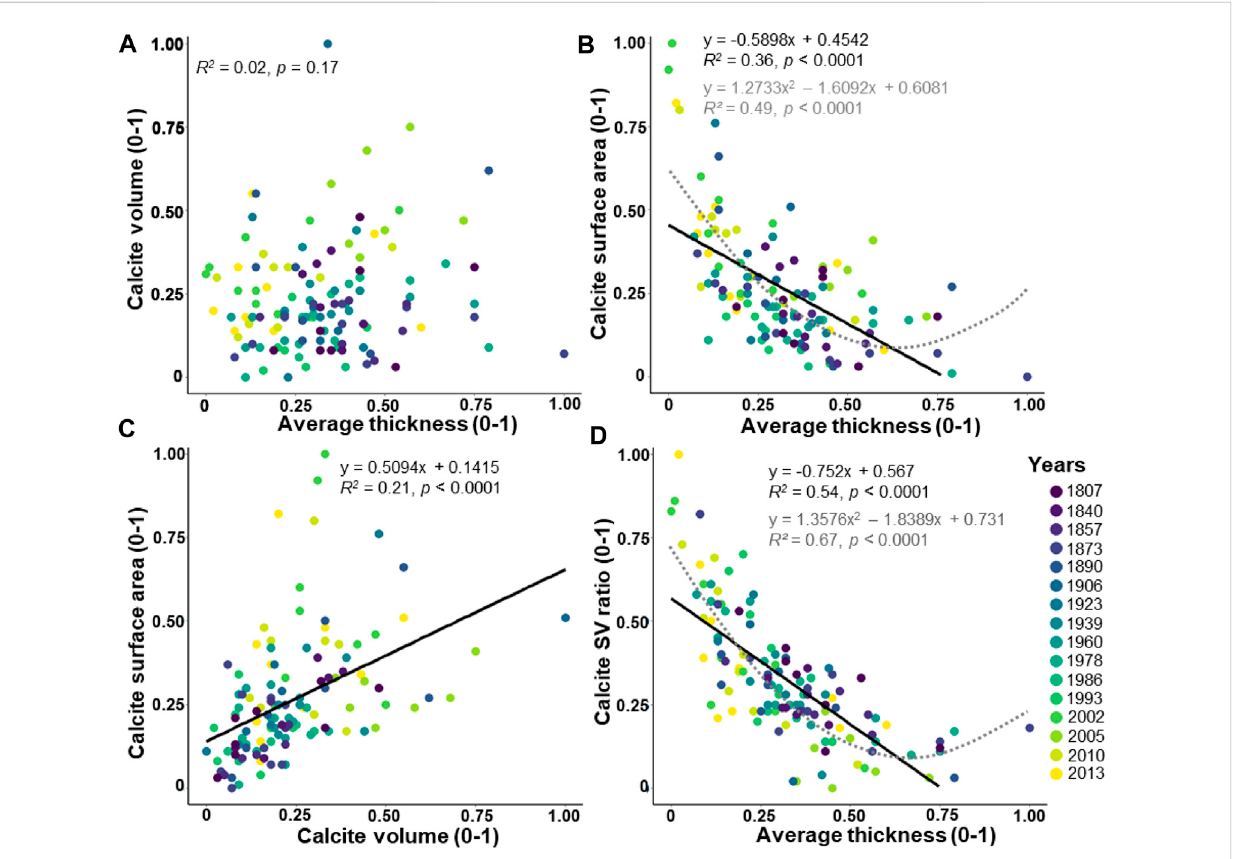
FIGURE 5 Relationships betweentheaverage thickness, thecalcitevolume, and thecalcite surface area. The values are adjusted between 0 and 1.The dataset includes 124 specimens of Elphidium clavatum from the Baltic Sea entrance over the last 200 years. (A) Calcite volume and average thickness. (B)